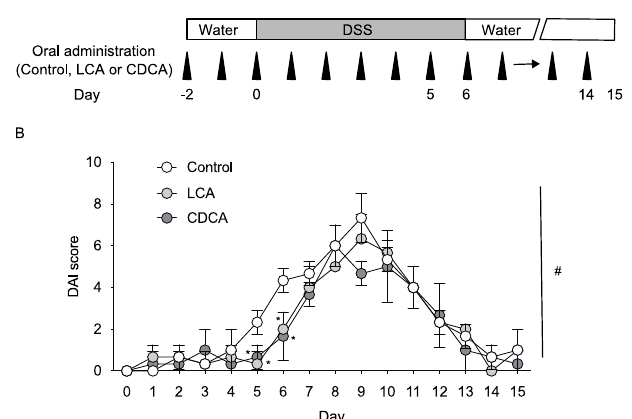
Figure 1. Effects of oral administration of LCA and CDCA on symptoms of colitis in DSS-treated mice. ( A ) Experimental procedure for oral administration of LCA and CDCA and DSS treatment in mice. Mice were orally administered control corn oil, LCA (in corn oil), or CDCA (in corn oil) from day − 2 to day 14. To generate colitis, mice received 3% DSS from day 0 to 6. n = 6 for each group. ( B ) Time course of DAI scores from day 0 to 15. # p < 0.05 (two-way ANOVA). Data are presented as means ± S.D. * p < 0.05 compared with control (one-way ANOVA followed by Tukey’s multiple